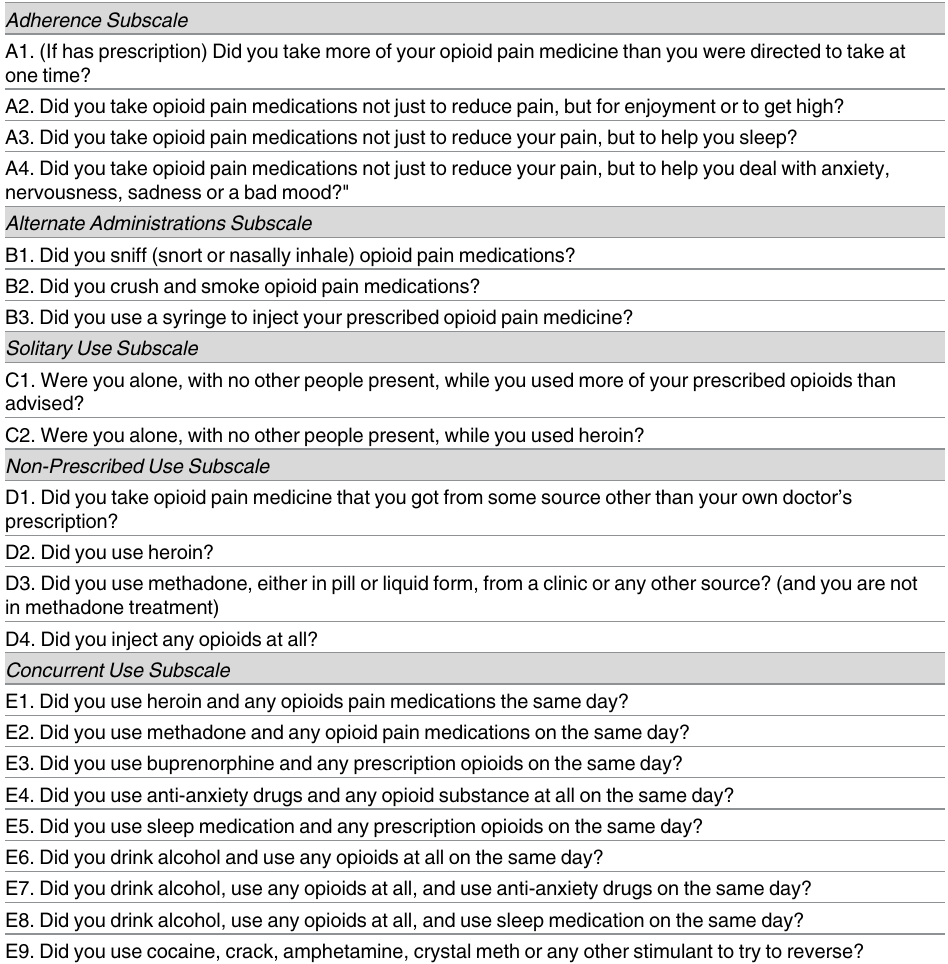
Table 1. Overdose Risk Behavior Scale (ORBS) items. On how many of the past 30 days